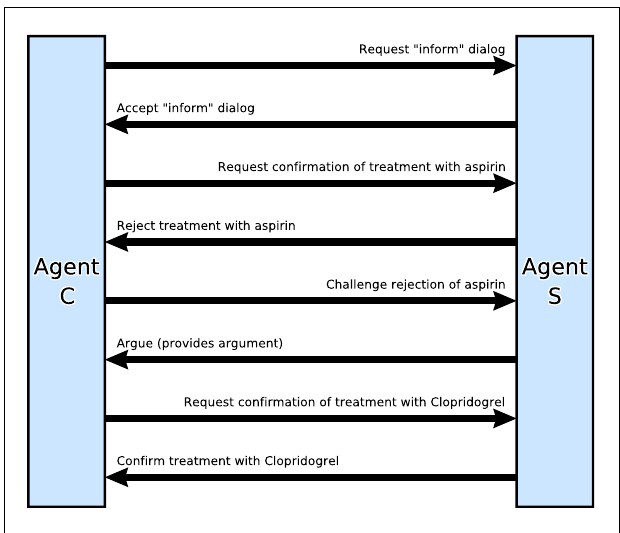
FIGURE 8 | Sequence diagram for some of the interactions between agent C and agent S during the joint decision-making